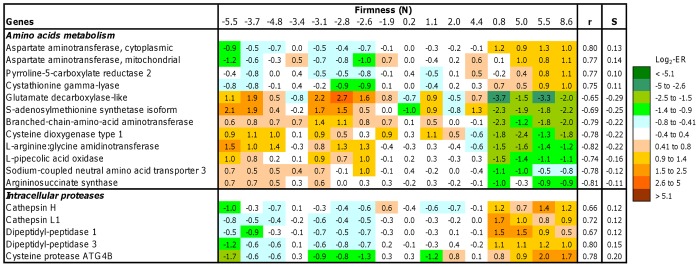
Expression of genes associated with amino acid metabolism and intracellular proteases in skeletal muscle of salmon with varying firmness (n = 16 fish).Data are log2-ER and are highlighted with a color key. r =  Pearson correlation coefficient, S =  coefficient of linear regression (S – slope).